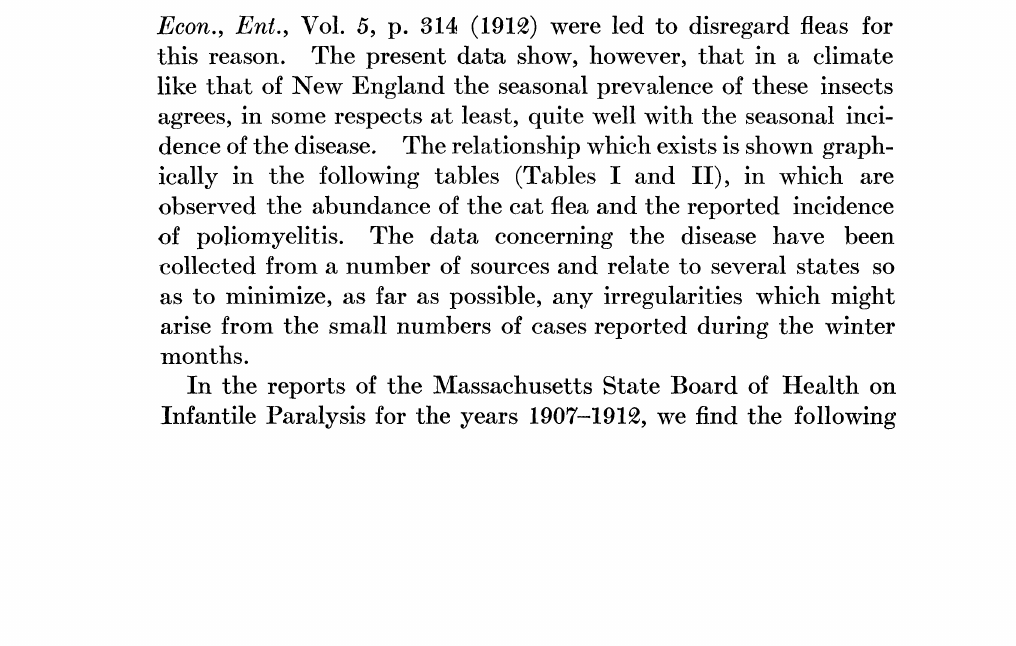
. Seasonal Abundance of the Cat Flea (Ctenocephalus